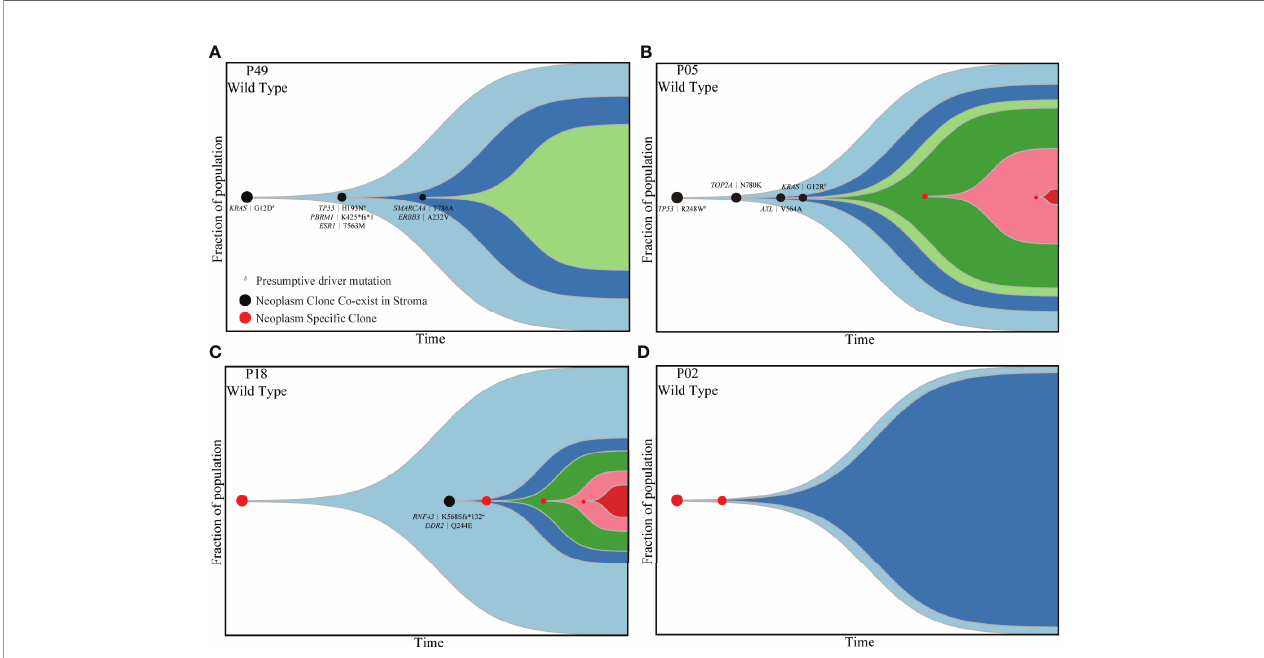
FIGURE 4 | Four types of patients demonstrating different evolutionary trajectories involving both stroma and neoplastic components. P49 (A) , P05 (B) , P18 (C) and P02 (D) presented four different subtypes of evolutionary trajectory. The black dots indicate clones shared by matched stroma and neoplasm. The red dots represent clones private to neoplastic components. The black characters indicate mutations shared by matched stromal and neoplastic components. The emergence and progression pattern of each clone are hypothesized according to the fraction of clonal population inferred from the average VAF of mutations involved in the same clone. VAF, variant allele frequency.